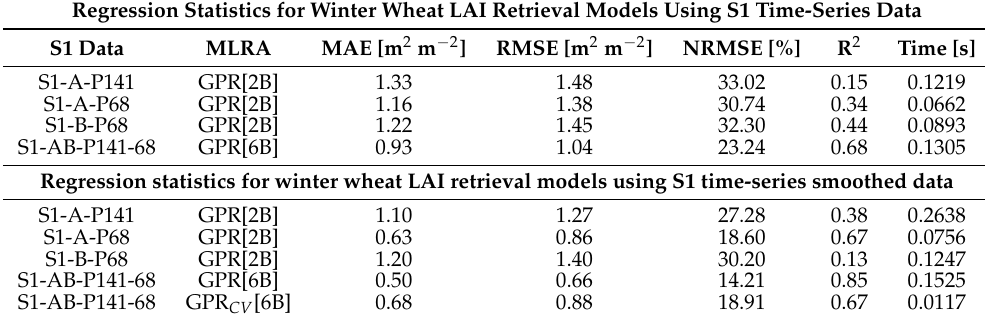
Table 3. Regression statistics for winter wheat LAI retrieval modeling using S1 time-series data. Regression Statistics for Winter Wheat LAI Retrieval Models Using S1 Time-Series